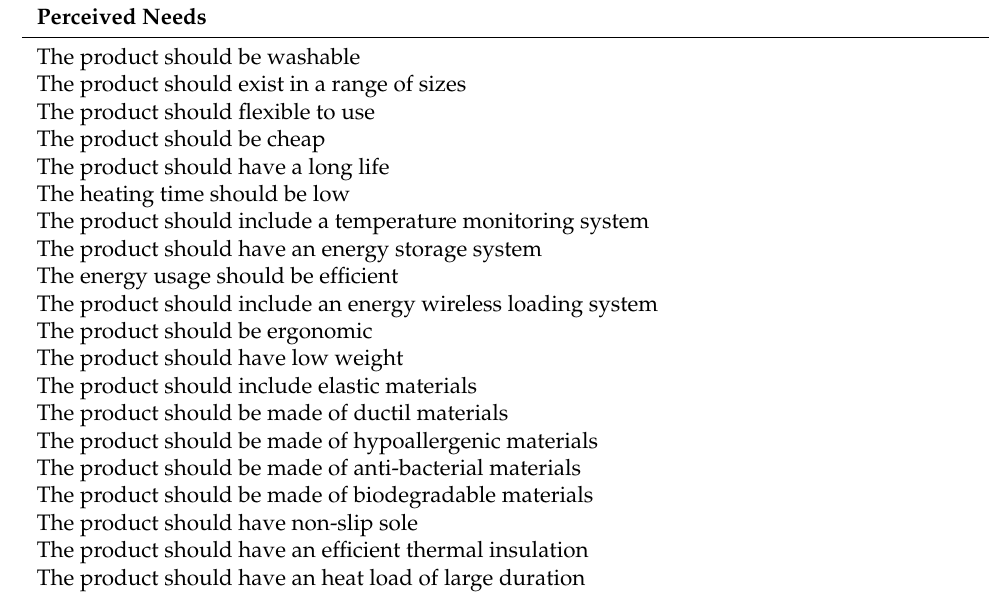
Table 1. Perceived needs interpreted from the focus